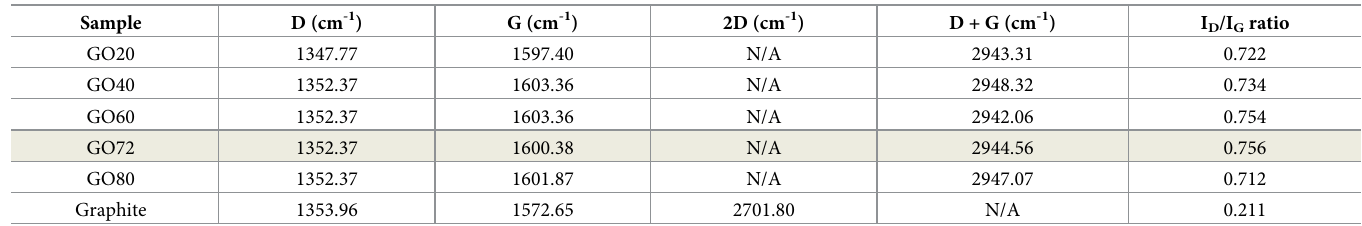
Table 4. Raman analysis of GO and graphite.